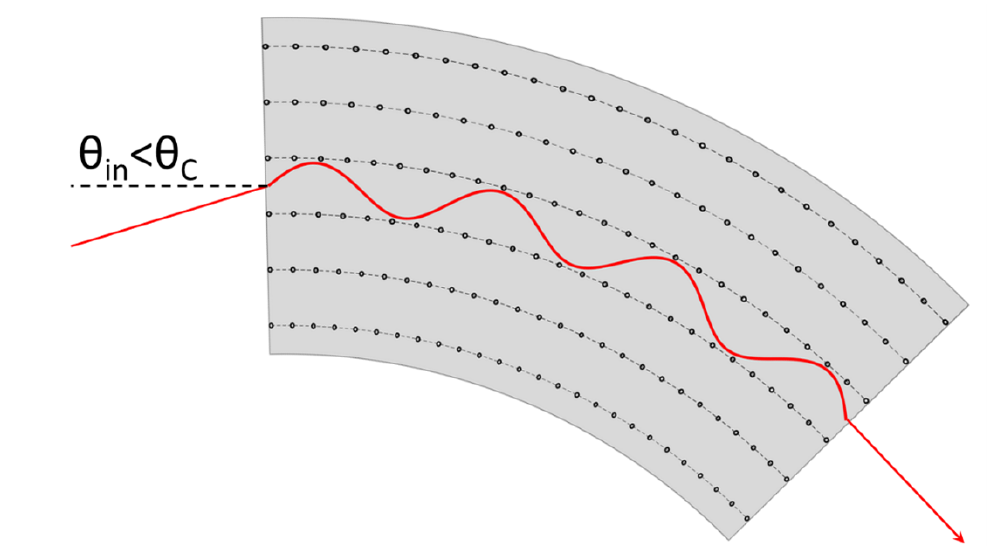
Figure 3. Sketch of positive particle trajectory during planar channeling in a bent crystal: if entry angle wrt planes is lower than the critical one θ c the particle is channeled between two adjacent atomic planes, following its curvature.